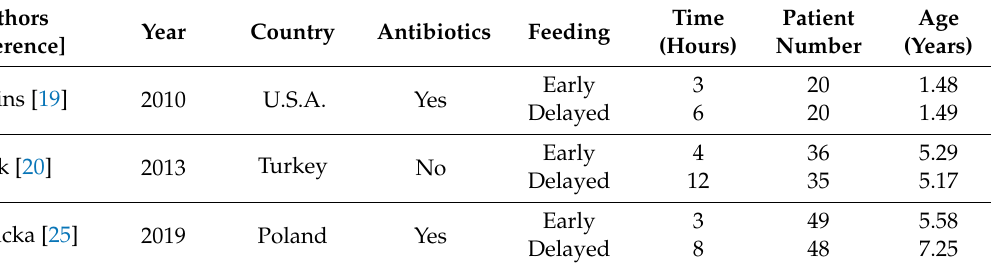
Table 1. Summary of the characteristics of the included studies.